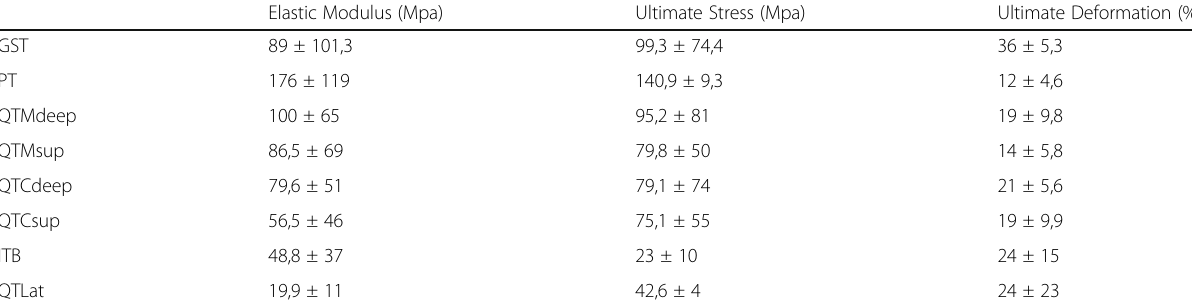
Table 2 Mechanical Testing results (Mean values and standard deviation) in term of Elastic moduli, Ultimate stress and Deformation Elastic Modulus (Mpa)